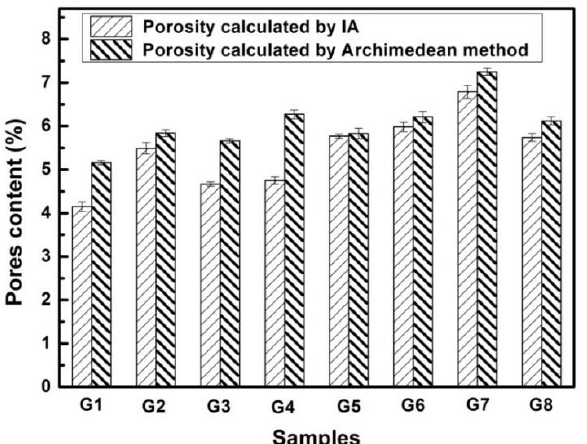
Figure 4. Porosity of as-sprayed gradient coatings determined by the image analysis (IA) and Archimedean methods.